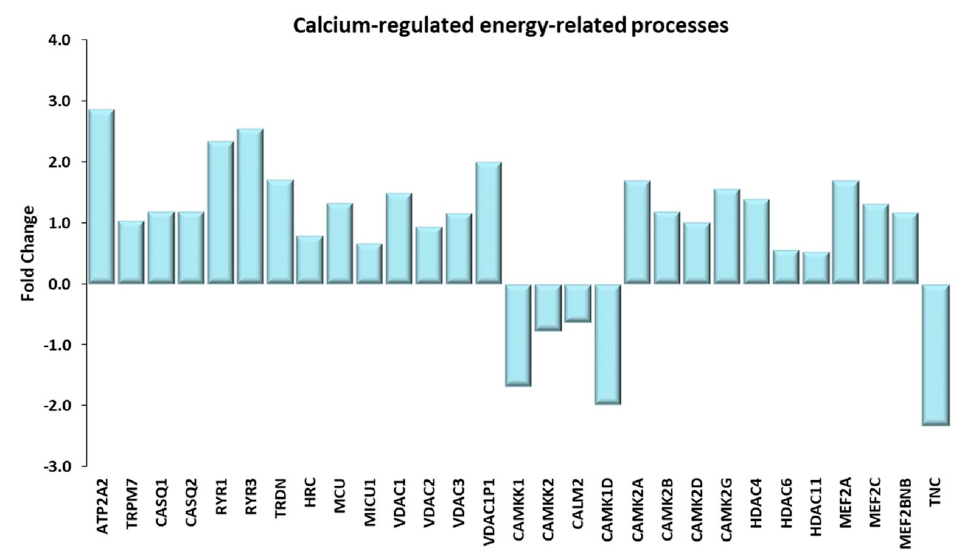
Figure 8. Calcium-regulated energy-related processes. Genes discussed in the text are shown here as fold change in the comparison of TRA and SED subjects. ATP2A2: ATPase sarcoplasmic / endoplasmic reticulum Ca 2 + transporting 2 or SERCA2; TRPM7: transient receptor potential cation channel subfamily M member 7; CASQ1, CASQ2: calsequestrin 1, 2; RYR1, RYR3: ryanodine receptor 1, 3; TRDN: triadin; HCR: histidine rich calcium binding protein; MCU: mitochondrial calcium uniporter; MICU1: mitochondrial calcium uptake 1; VDAC1, VDAC2, VDAC3, VDAC1P1: voltage dependent anion channel 1, 2, 3, 1 pseudogene 1; CAMKK1, CAMKK2: calcium / calmodulin dependent protein kinase kinase 1, 2; CALM2: calmodulin 2; CAMK1D: calcium / calmodulin dependent protein kinase ID; CAMK2A, CAMK2B, CAMK2D, CAMK2G: calcium / calmodulin dependent protein kinase II α , II β , II δ , II γ ; HDAC4, HDAC6, HDAC11 histone deacetylase 4, 6, 11. MEF2A, MEF2C: myocyte enhancer factor 2A, 2C; MEF2BNB: BLOC-1 related complex subunit 8; TNC, tenascin C.